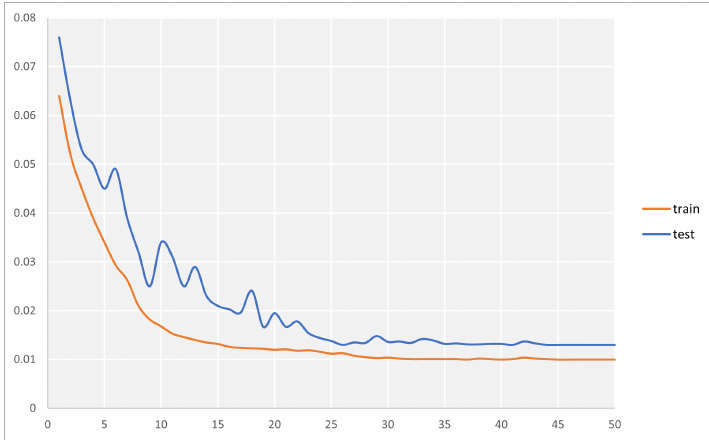
Figure 9. Convergence curve of CNN model.